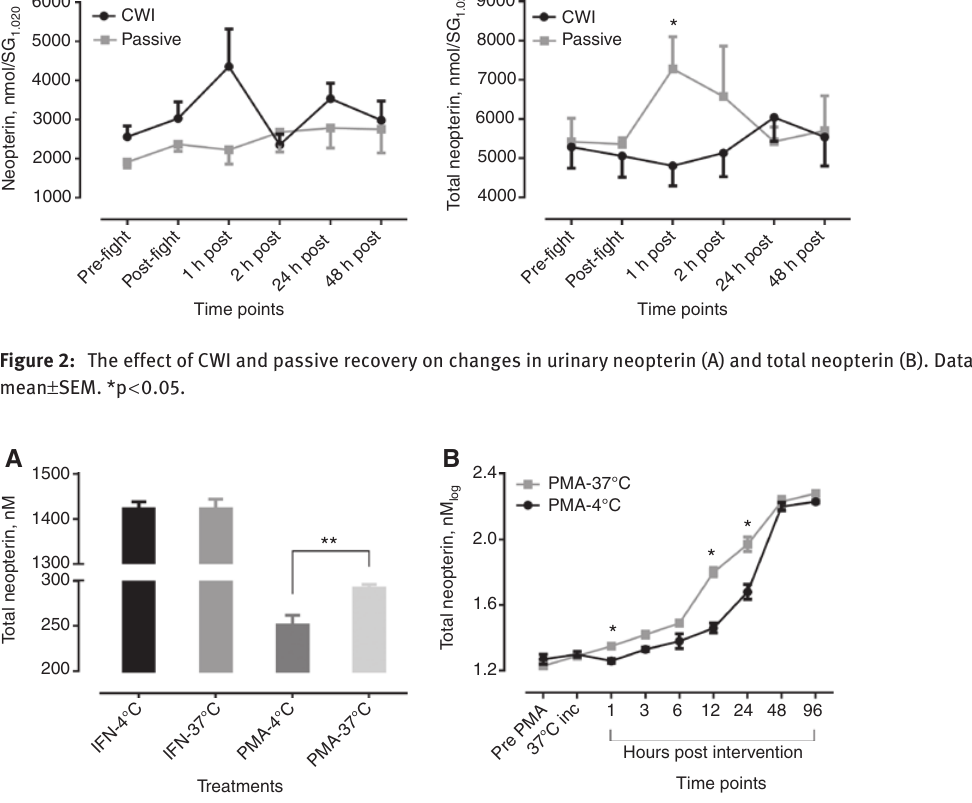
Figure 3: Effect of cold treatment on total neopterin production by mononuclear cells. Blood-derived mononuclear cells consisting of a mixture of T cells and monocytes were stimulated with either 500 U of γ -interferon or 5 μ mol/L of PMA. (A) After 1 h of incubation, selected plates (containing 10 × 10 6 /well) as indicated were transferred to a 4 ° C fridge for 1 h before being returned to the 37 ° C incubator. The remain- ing plates were left at 37 ° C for the entire 24 h before the media was sampled for total neopterin release. (B) Release of total neopterin into the media was measured at the indicated time points following stimulation with 5 μ mol/L of PMA using the cold treatment specified for (A). Each data point is the mean of three individual wells for each time point consisting of 5 × 10 6 cells/well. Data were log transformed and presented as the mean ± SEM. *p <